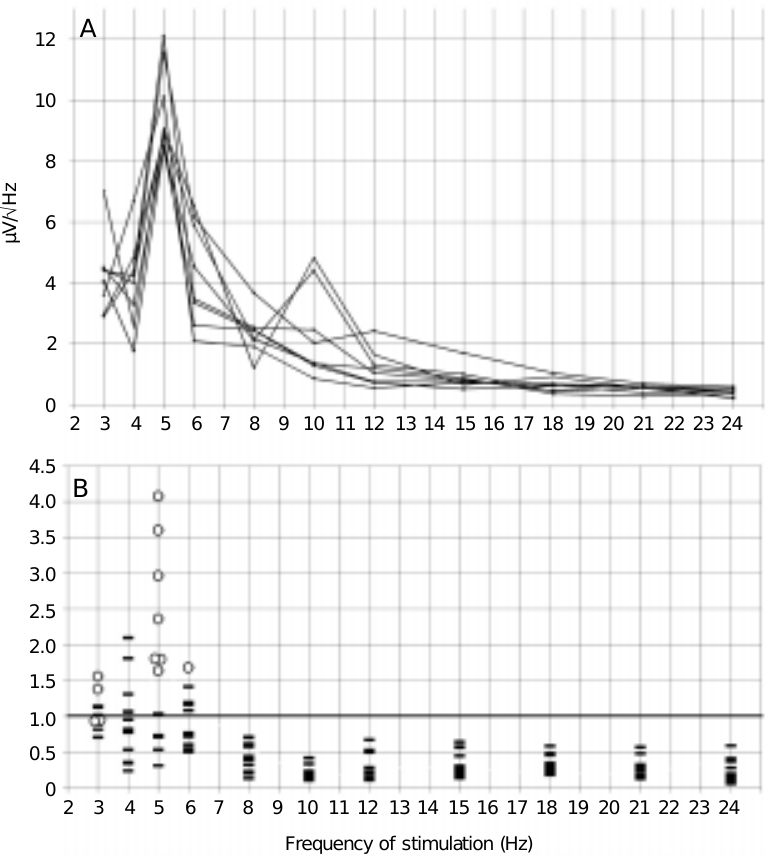
Figure 5. Driving profiles for second harmonic. A , Superposition of profiles for 8 subjects who had a profile maximum during intermittent photic stimulation at 5 Hz (see Figure 1). B , Superposition of amplitude ratios “second harmonic/first harmonic” in 12 subjects. Circles: maximum of the ratios in each subject. The abscissae show the frequency of